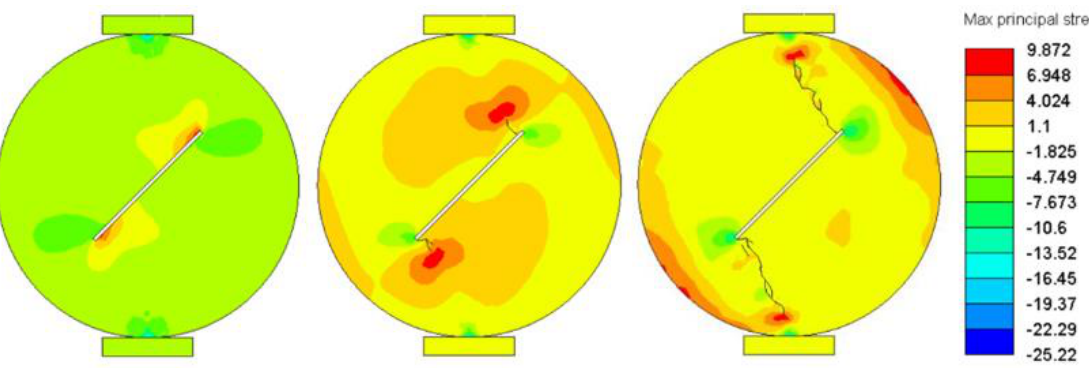
Figure 13. Evolution of maximum principal stress for Brazilian disc with crack of 45° angle.